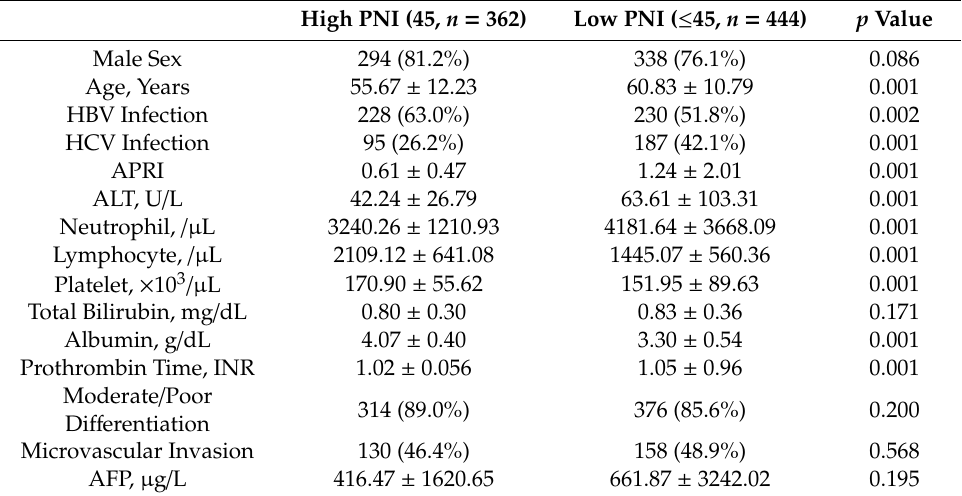
Table 6. Comparison of characteristics between patients with high and low